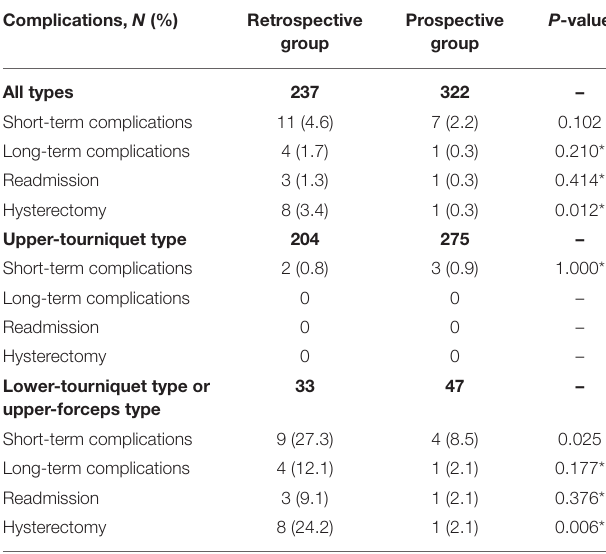
TABLE 4 | Comparison of different surgical methods of